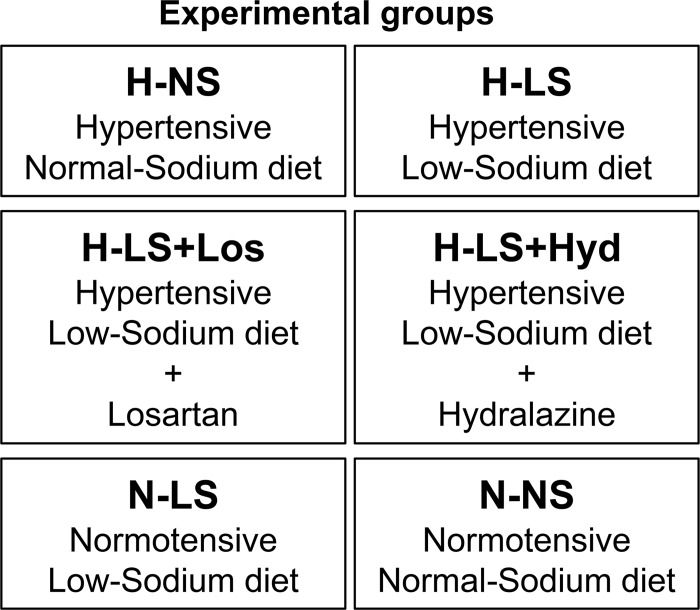
Experimental groups.